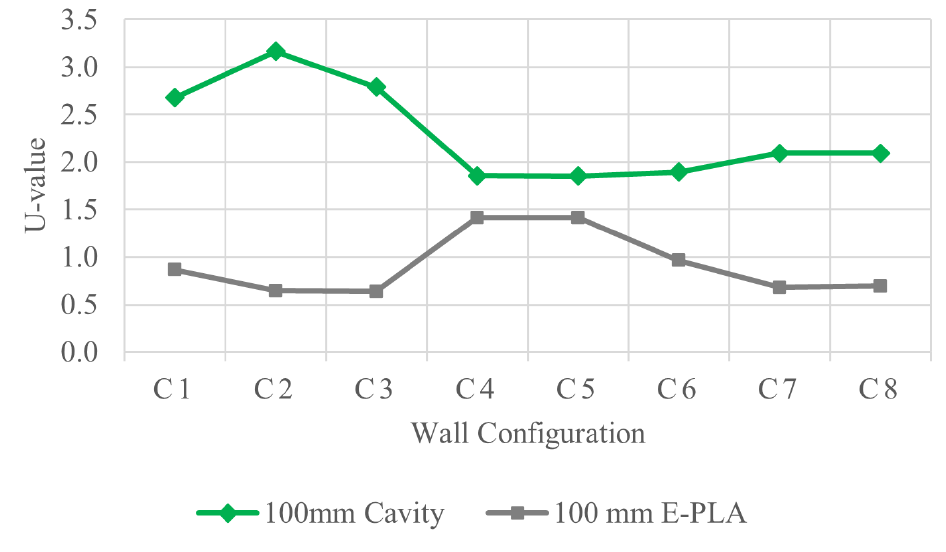
Figure 7. The U -value results obtained for 100 mm wall configurations with and without cavity insulation. Figure 7. The U-value results obtained for 100 mm wall configurations with and without cavity Table 7. The U -value reduction percentages (%) with insulation.